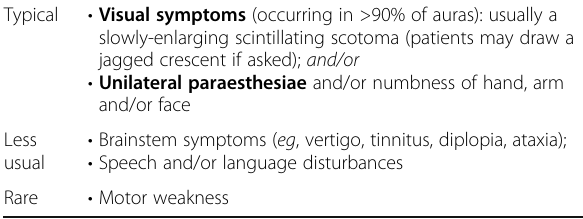
Table 3 Symptoms of aura (developing gradually over ≥ 5